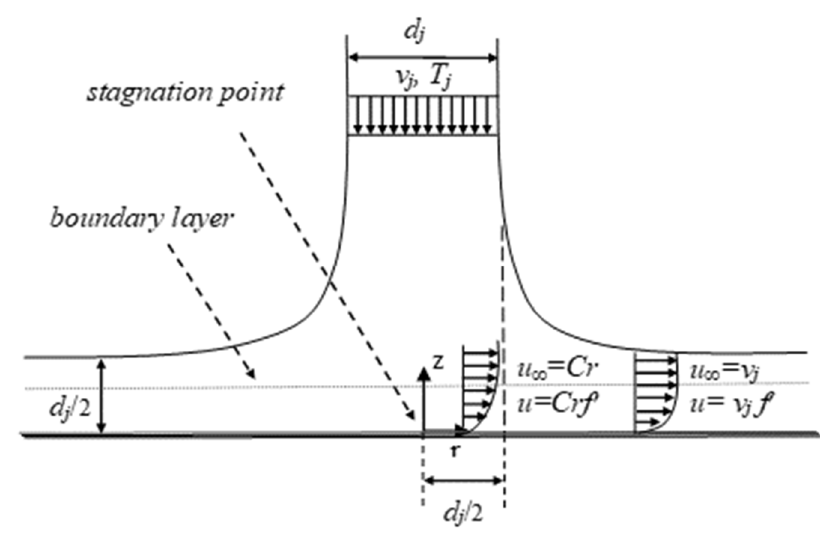
Figure 1. Axisymmetric stagnation flow profile of an impinging circular jet.